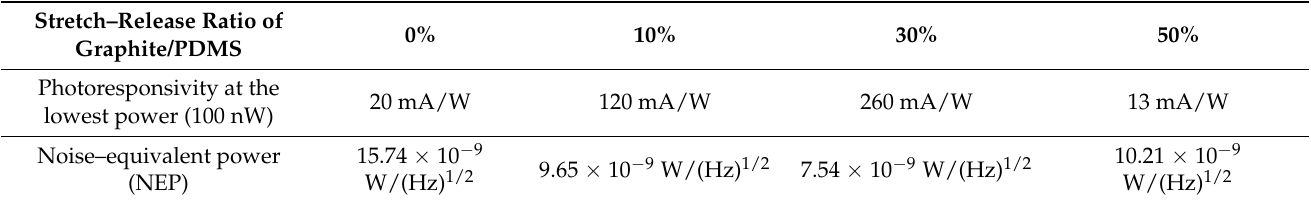
Table 1. The merit of photoresponsivity and noise-equivalent power (NEP) values of optical sensing devices based on stretched PDMS/rippled graphite at different stretch:release ratios under 532 nm laser